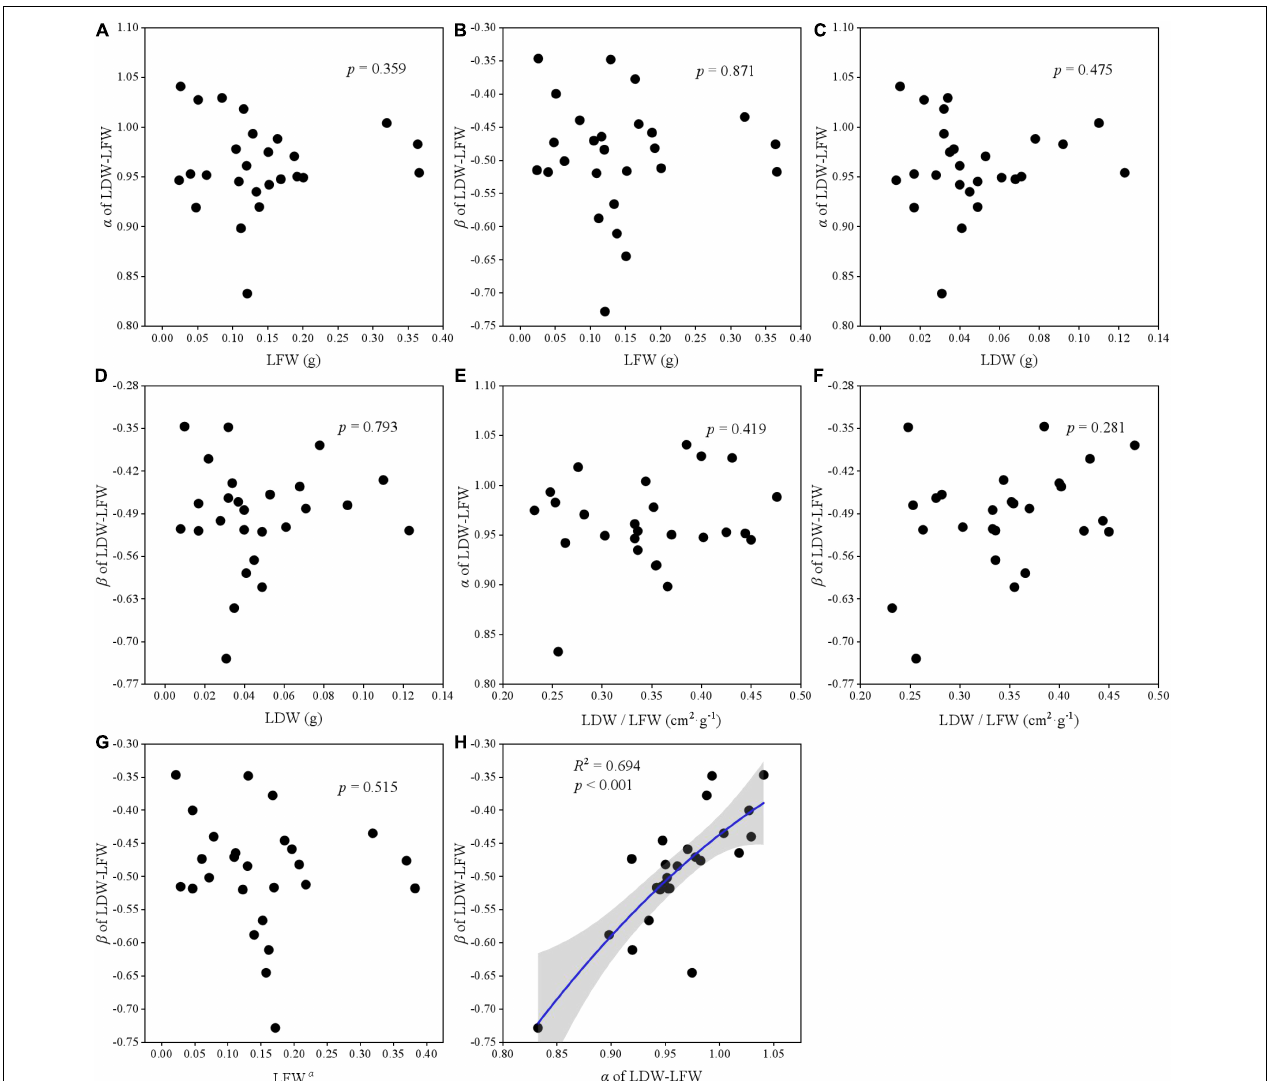
FIGURE 5 | The correlation relationship of parameters of LDW and LFW. (A) The relationship between α and LFW; (B) the relationship between β and LFW; (C) the relationship between α and LDW; (D) the relationship between β and LDW; (E) the relationship between α and LDW/LFW; (F) the relationship between β and LDW/LFW; (G) the relationship between β and LFW α ; and (H) the relationship between β and α